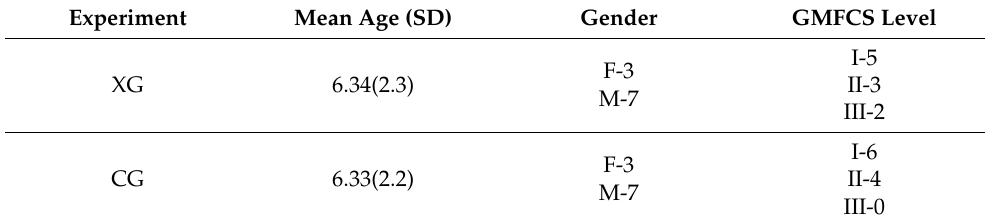
Table 1. Demographic data.